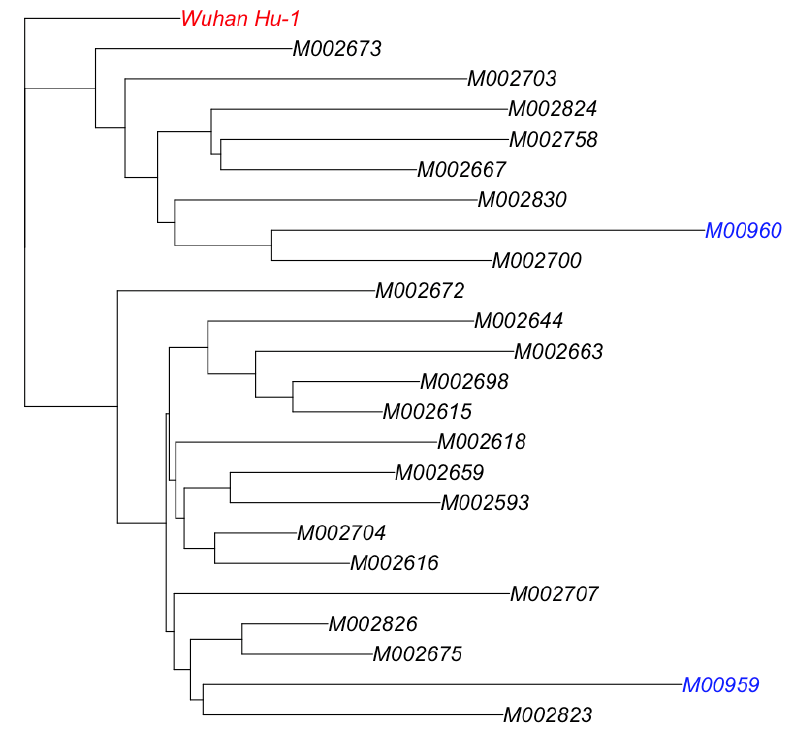
Figure 5. Neighbor-joining phylogenetic